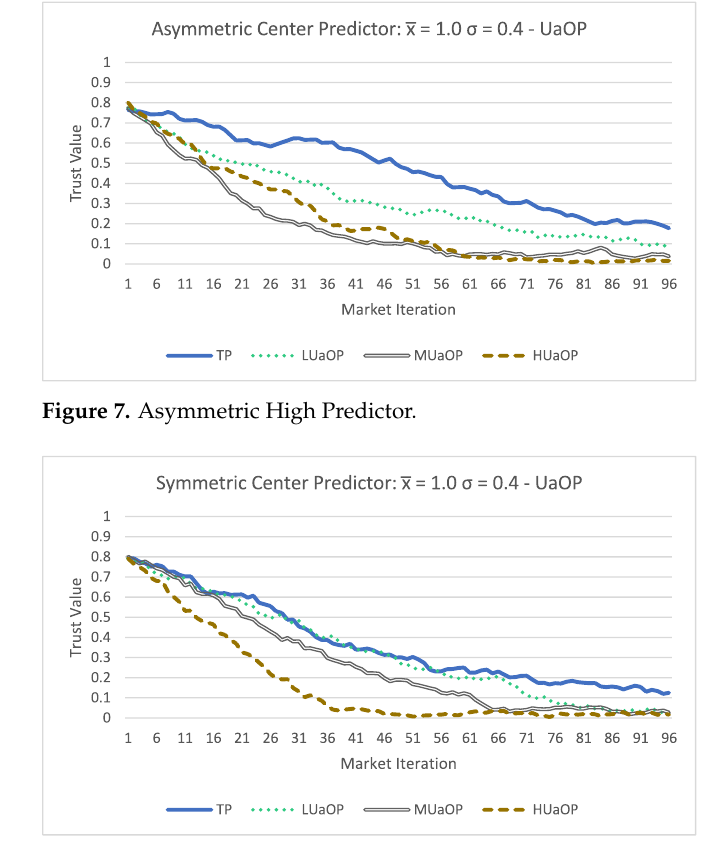
Figure 8. Symmetric High